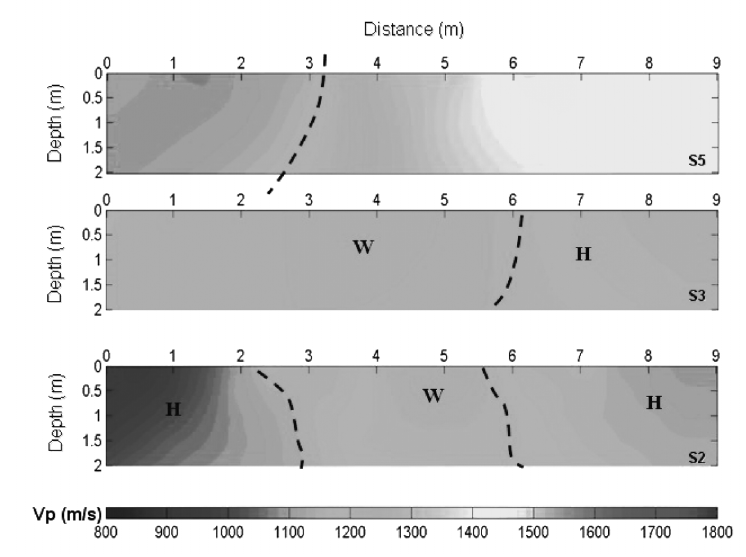
Fig. 4. P -wave velocity